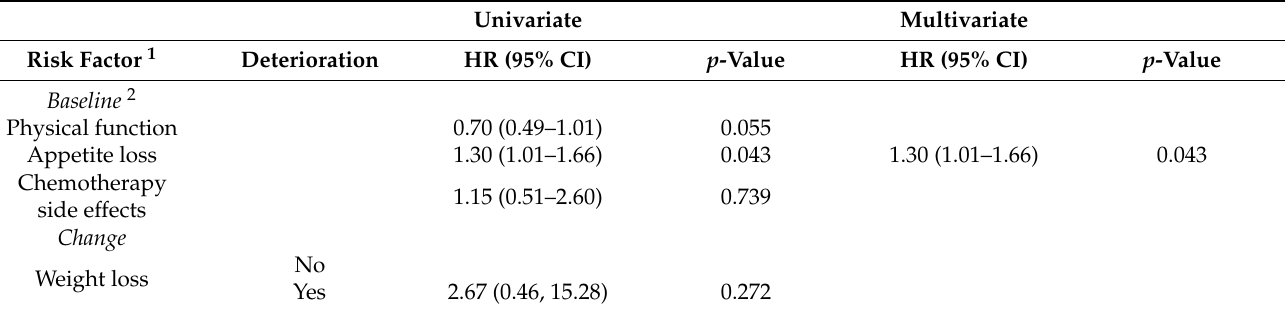
Table 2. M0 compared to M1 for quality of life baseline and change scores using the t -test. Table 3. Overall survival of age-adjusted hazard ratios for M1 patients baseline and change scores QLQ C30 and QLQ CR38.